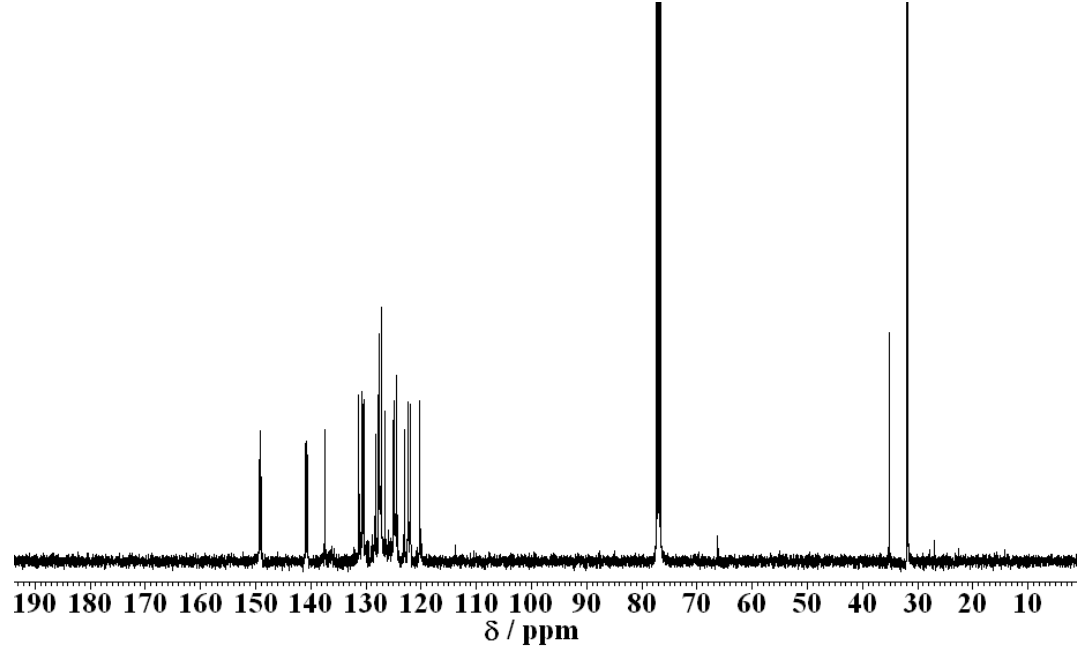
Figure S2. 13 C-NMR spectrum of 2,2 ′ ,7,7 ′ -tetrakis(7- tert -butyl-1-pyrenyl)-9,9 ′ -spirobi